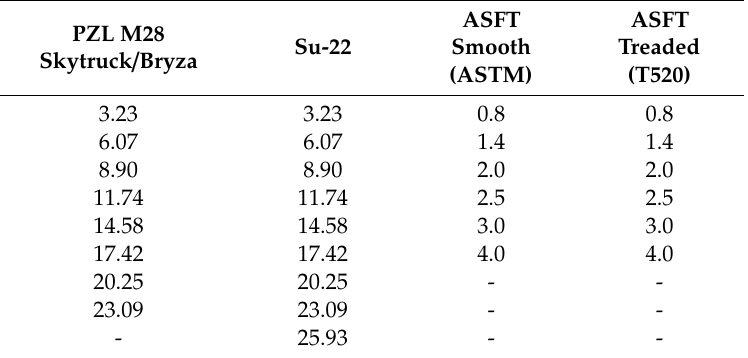
Table 2. Values of wheel pressure on the plate during measurements for individual types of tires (values given in kN). ASFT ASFT PZL M28 Su-22 Smooth Skytruck / Bryza (T520) (ASTM)